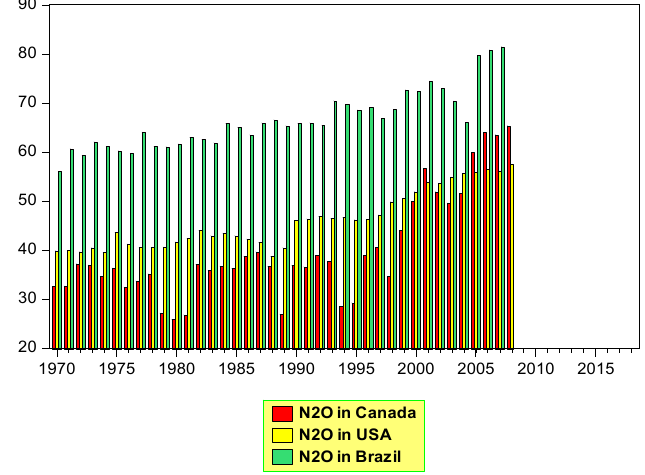
Figure 3. The evolution of N 2 O in Canada, USA and Brazil.